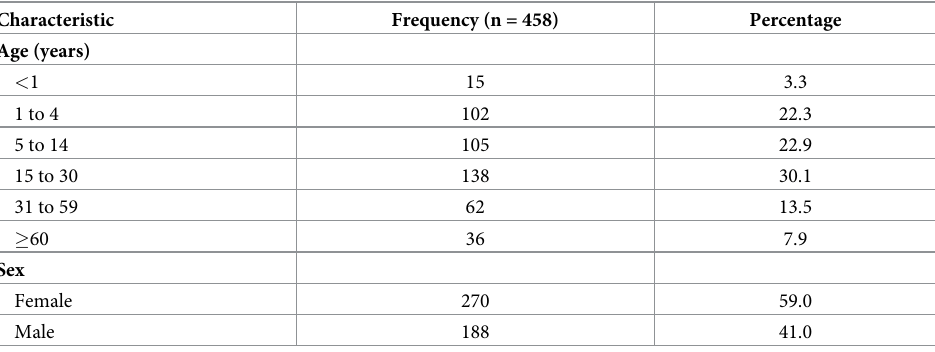
Table 1. Description of the study population.